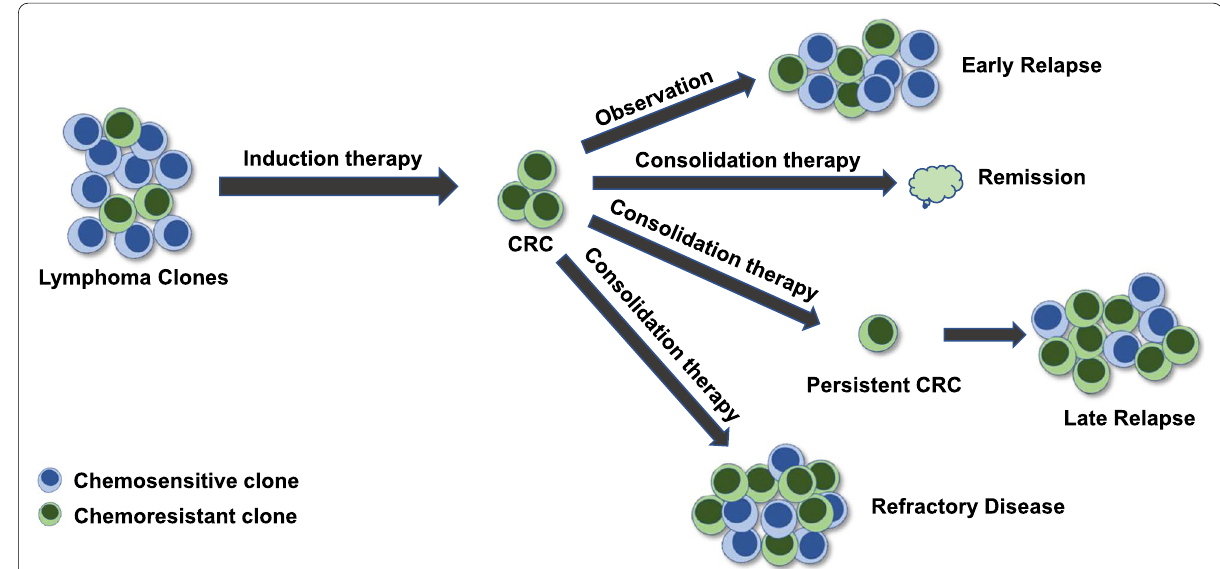
Fig. 4 Drug-resistant subclones modulating relapse and refractory disease course in B-cell